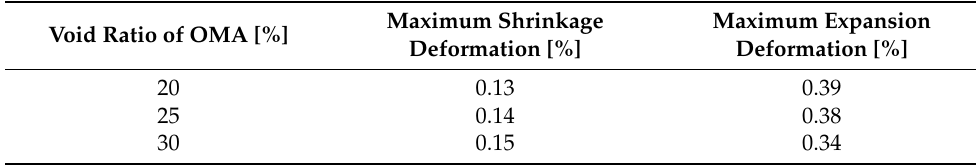
Table 8. Recommended deformation indexes of cement mortar in GSP [71].